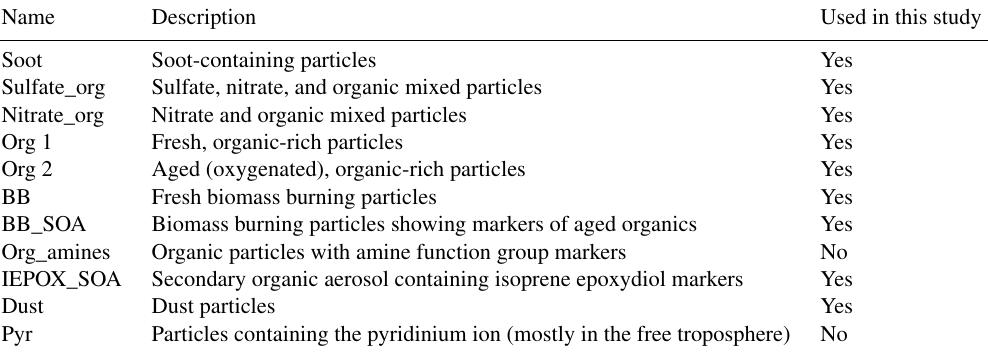
Table 2. Particle classes defined from miniSPLAT single-particle measurements.